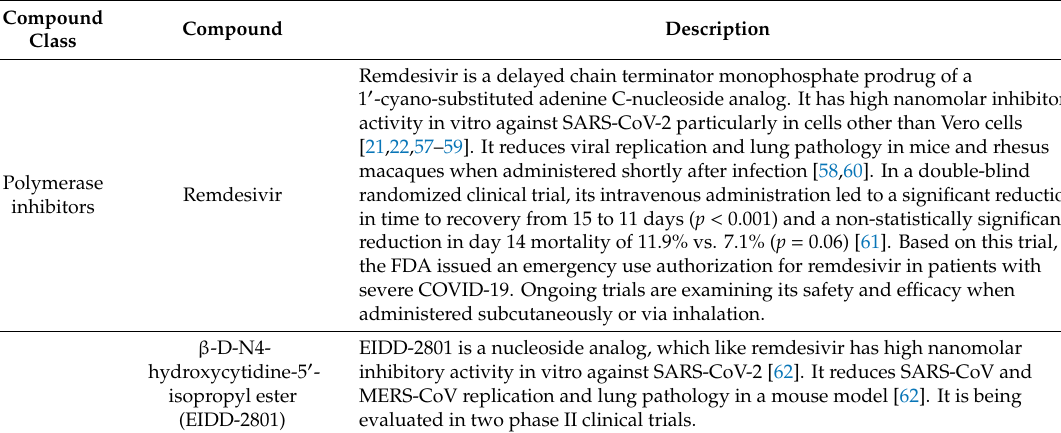
Table 4. Promising SARS-CoV-2 antiviral compounds.